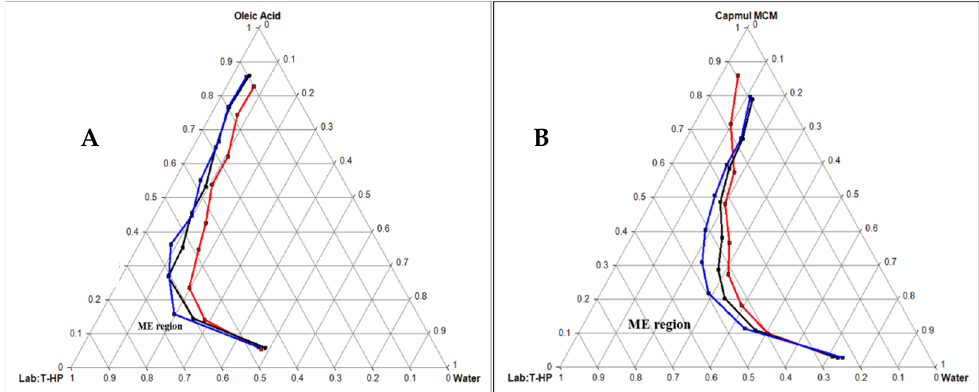
Figure 2. Pseudo ‐ ternary phase diagram of Oleic acid oil ( A ) and Capmul MCM EP oil ( B ) with S mix ratio (Labrasol and Transcutol ‐ HP = 1:1 in red line, 2:1 in black line, and 3:1 in blue line.